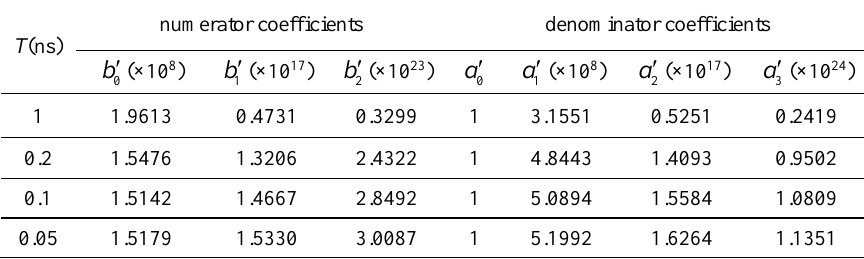
Table 2. Numerator and denominator parameters of δ -domain system model of B